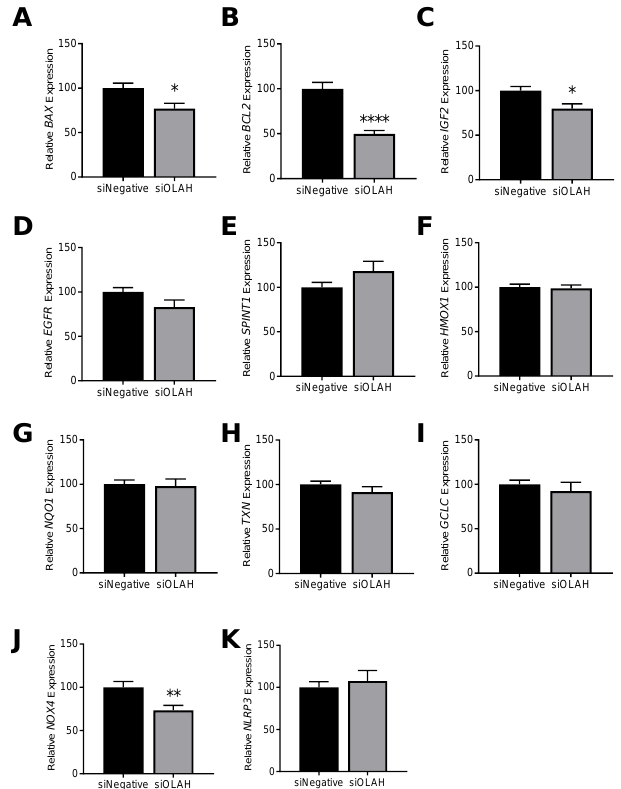
Figure 7. Effect of silencing cytotrophoblast OLAH on the expression of genes associated with apoptosis, growth, inflammation, and oxidative stress under hypoxia. Silencing OLAH significantly reduced expression of pro-apoptotic BAX ( A ) and anti-apoptotic BCL2 ( B ) under hypoxia. Silencing OLAH significantly reduced cytotrophoblast expression of IGF2 ( C ), but did not significantly alter EGFR ( D ), or SPINT1 ( E ) expression, genes associated with fetal growth. Anti-oxidant genes HMOX1, NQO1, TXN, and GCLC ( F – I , respectively) were not significantly altered with OLAH knockdown in cytotrophoblast cells under hypoxia. Oxidative stress gene, NOX4, was significantly reduced with OLAH knockdown under hypoxia ( J ), but inflammasome gene, NLRP3 was not significantly altered ( K ). Results presented as relative change compared to control; mean ± SEM. n = 3, each sample from a different patient. * p < 0.05, ** p < 0.01, **** p <